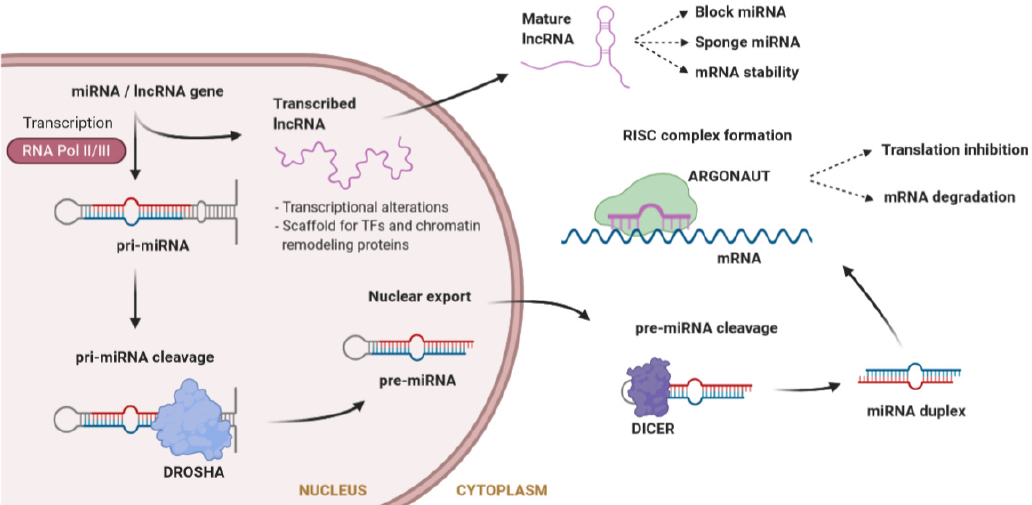
Figure 2. Synthesis of microRNAs (miRNAs) and long non-coding RNAs (lncRNAs), as well as mechanisms of action. miRNA biogenesis consists of a series of steps where a premature miRNA is cleaved until it reaches the mature form outside the nucleus. Both miRNAs and lncRNAs can interfere with gene regulation through different mechanisms. lncRNAs also interfere in the function of other miRNAs.